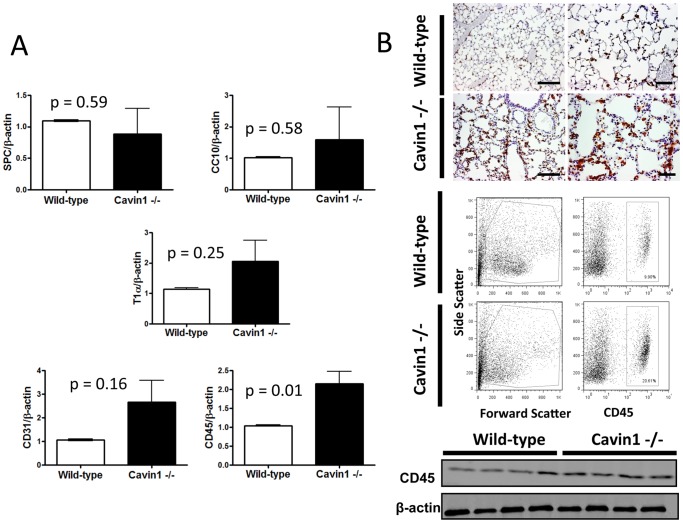
Leukocytes are increased in the lungs of Cavin1−/− mice.A) Transcript levels for structural and non-structural cells in lung of wild-type and Cavin1−/− mice. Transcript levels for the hematopoietic marker CD45 are increased in the lungs of Cavin1−/− mice. Statistically significant differences were not observed in transcript levels for SPC, CC-10, T1α, CD31 in the lungs of wild-type and Cavin1−/− mice (n = 5 or greater in all groups, two replicates). B) CD45-positive cells are increased in the lungs of Cavin1−/− mice. (Top) Immunohistochemistry staining for mouse CD45. Brown straining represents CD45+ expressing cells. (Middle) Flow cytometry analysis of CD45 stained lung digests from wild-type and Cavin1−/− mice (n = 6 wild-type and Cavin1−/− mice). Doublets, red blood cells and dead cells were excluded from analysis. (Bottom) Western blot analysis for CD45 in lungs from wild-type and Cavin1−/− mice.